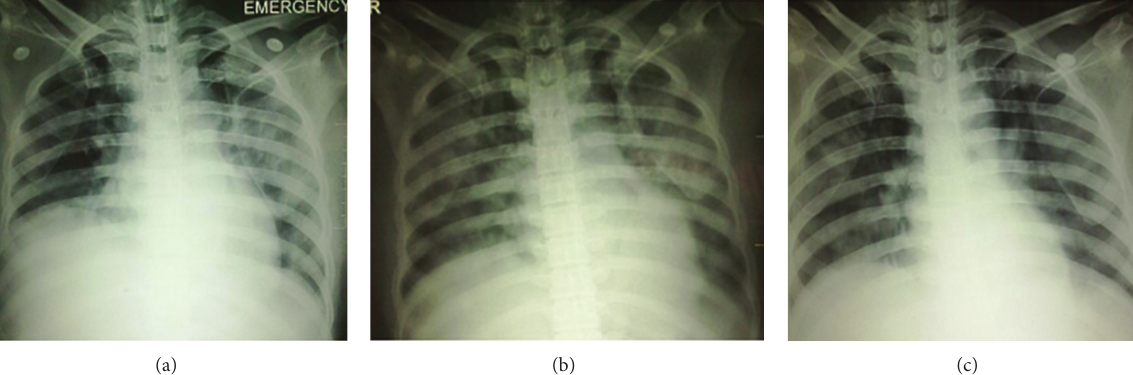
Figure 2: (a) CXR revealing left hilar infiltrates. (b) CXR eight hours later with bilateral hilar infiltrates. (c) CXR 24 hours later with reduction in bilateral hilar infiltrates following diuretics and